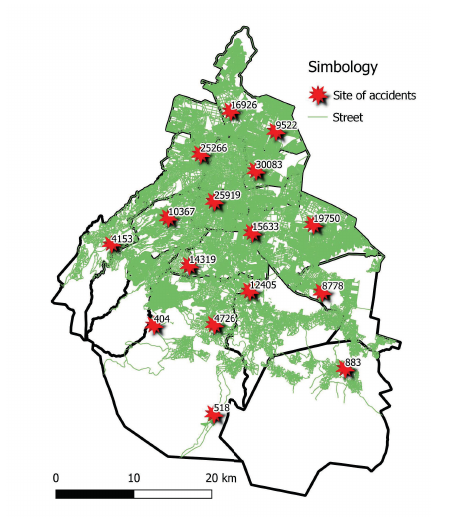
Figure 3. Location of ambulance bases. Source: Own preparation Base